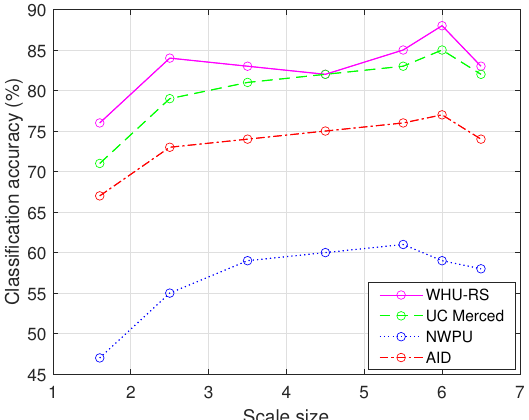
Figure 7. Classification accuracy of the proposed method under different Gaussian scales for four datasets.